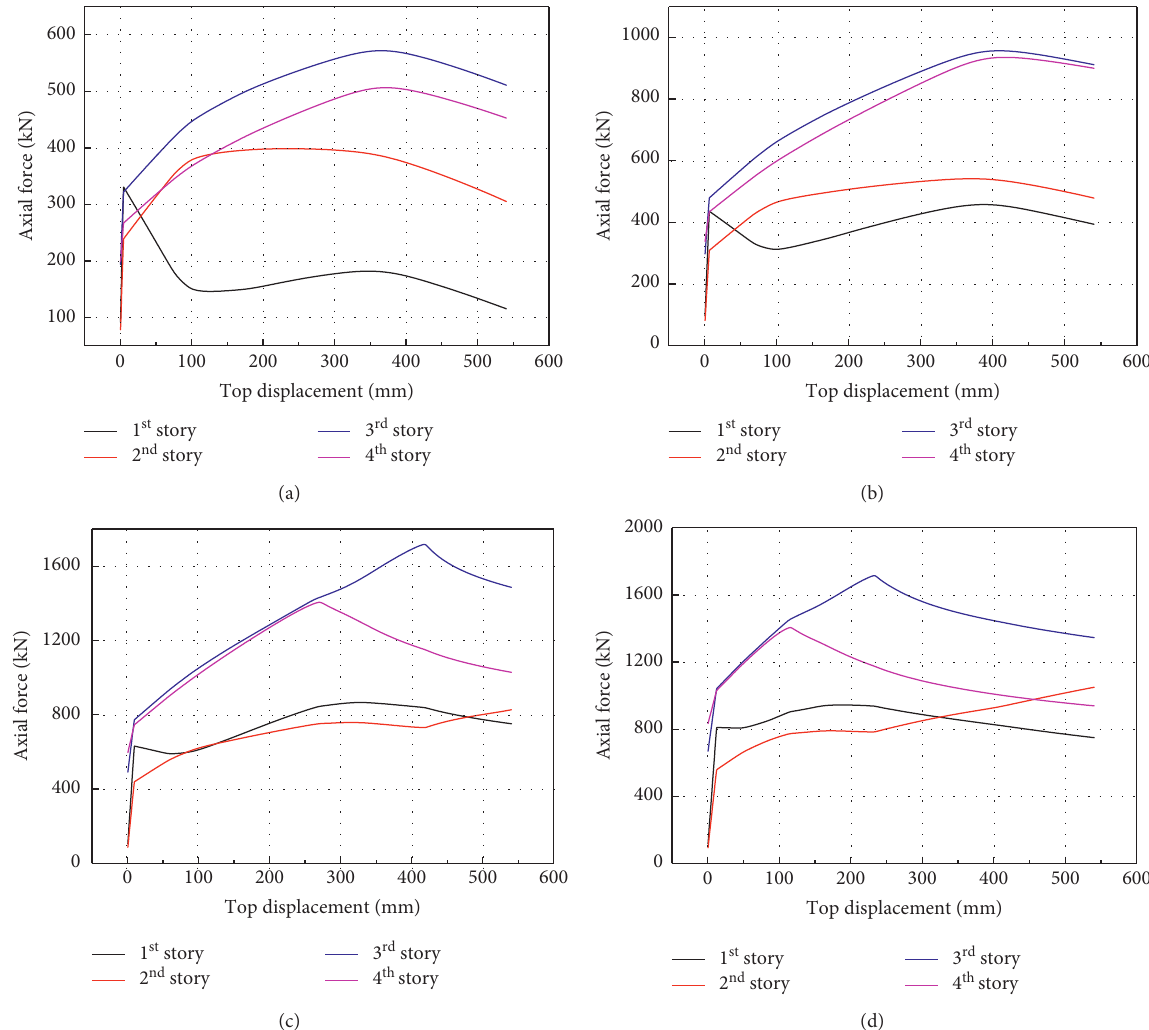
Figure 28: Pushover results of bracing axial force versus top displacement with different areas in each story: (a) 1/2 A ; (b) A ; (c) 2 A ; (d) 3 A